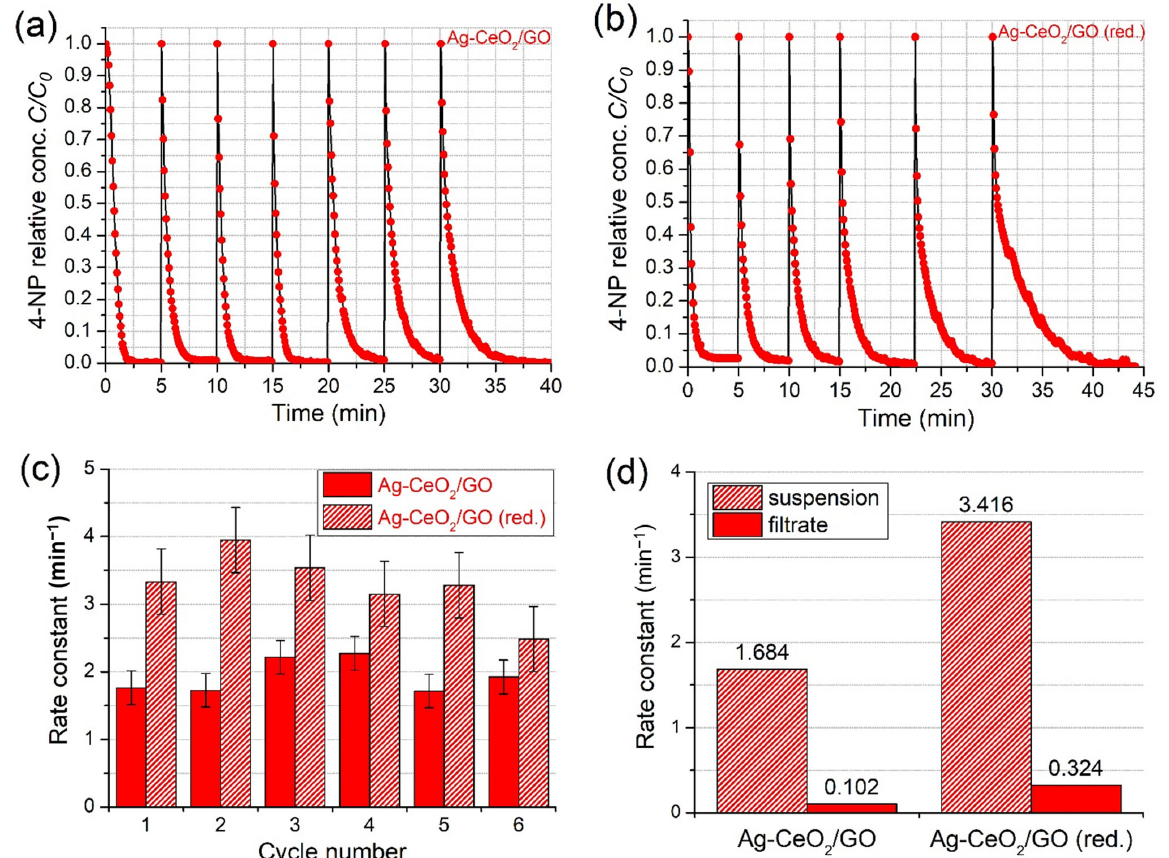
Figure 10. As-prepared Ag-CeO 2 /GO ( a ) and pre-reduced Ag-CeO 2 /GO (red.) ( b ) kinetic curves and the Figure 10. As ‐ prepared Ag ‐ CeO 2 /GO ( a ) and pre ‐ reduced Ag ‐ CeO 2 /GO (red.) ( b ) kinetic curves and the corresponding rate constant values of 4 ‐ NP reduction consecutive cycles ( c ); rate constant values corresponding rate constant values of 4-NP reduction consecutive cycles ( c ); rate constant values of 4-NP of 4 ‐ NP reduction with Ag ‐ CeO 2 /GO and Ag ‐ CeO 2 /GO (red.) suspensions and their filtrates ( d ). reduction with Ag-CeO 2 /GO and Ag-CeO 2 /GO (red.) suspensions and their filtrates ( d ). Experimental Experimental conditions: C (4 ‐ NP) = 7.5 ∙ × 10 –5 M, C (NaBH 4 ) = 0.015 M, C (catalyst) = 0.03 g/L), T = 297 conditions: C (4-NP) = 7.5 × 10 − 5 M, C (NaBH 4 ) = 0.015 M, C (catalyst) = 0.03 g/L), T = 297 K.